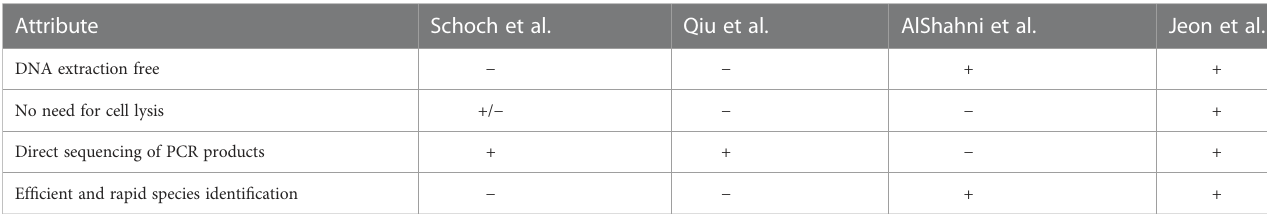
TABLE 2 Comparison of PCR approaches for fungal identi fi cation. Attribute Schoch et al. DNA extraction free